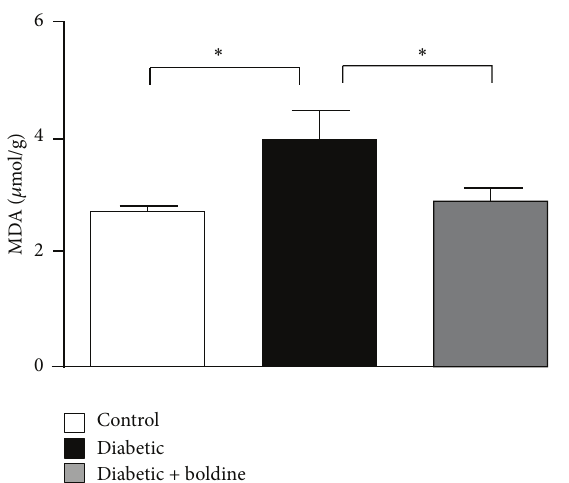
Figure 5: Boldine prevents lipid peroxidation in mesangial cells growninhighglucoseandproinflammatorycytokines.Graphshow- inglevelsofTBARS(MDA)intheculturemediumofmesangialcells cultured for 48 h, under normal glucose (white bar), high glucose + cytokines (TNF- 𝛼 (10ng/mL) and IL-1 𝛽 (10ng/mL)) (black bar), or high glucose + cytokines treated with 100 𝜇 M boldine during the last 24h (grey bar). Values are expressed as 𝜇 mol of MDA per g of protein in the culture medium. Each bar represents the mean value ± SEM of 4 independent experiments. ∗∗ 𝑃 ≤ 0.01 , using one-way ANOVA test followed by Bonferroni’s post hoc